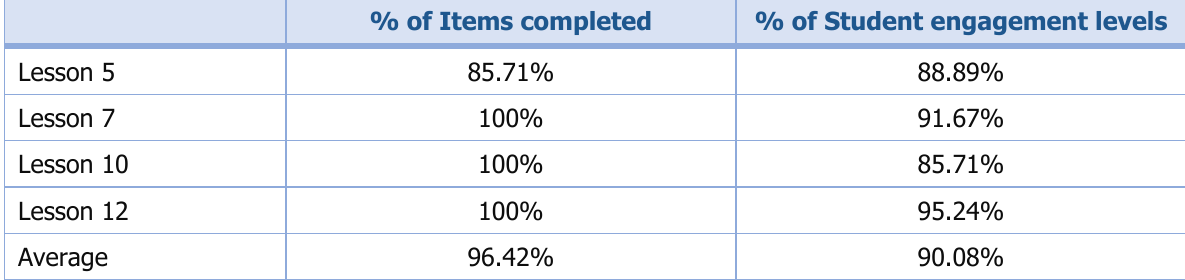
Table 1. Significance of Fidelity Measures and Student Engagement